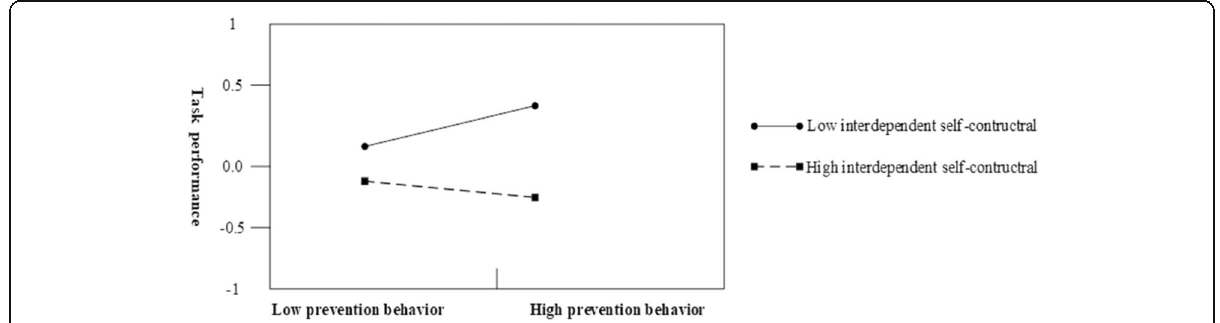
Fig. 7 Moderating effect of interdependent